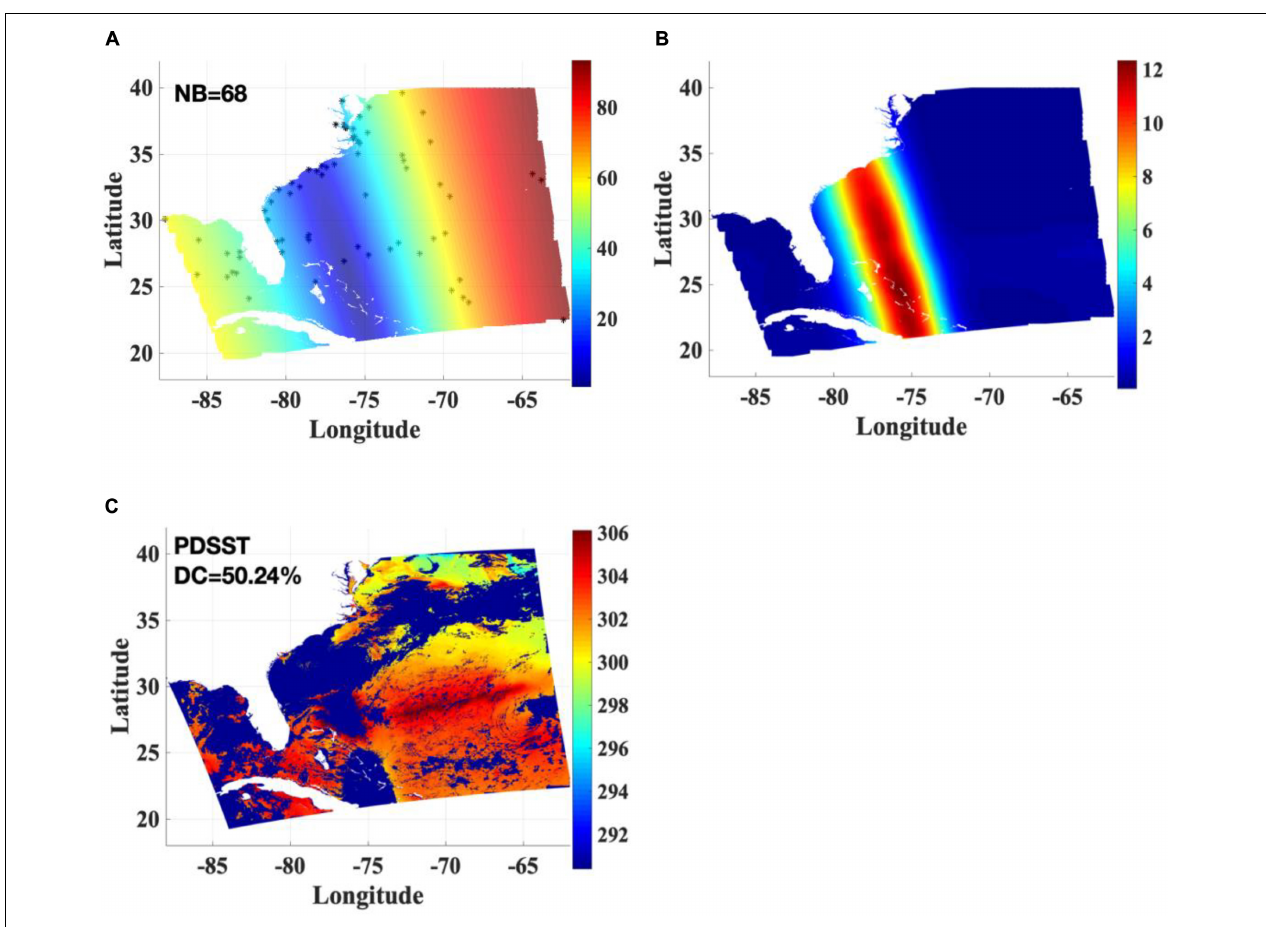
FIGURE 1 | Single swath maps: (A) Specular angle ( θ spec ) and the locations of in situ (Unit of color bar is degree), (B) Differences of the simulated BTs of 3.9 µ m channel between daytime and “nighttime equivalent” using CRTM (Unit of color bar is K), and (C) Retrieved SSTs using PDSST-suite (Unit of color bar is K). In situ locations are plotted using “*”. DC and NB stand for data coverage (cloud-free pixels) and the numbers of buoys, respectively. The ranges of longitude and latitude from − 180 ◦ to 180 ◦ and from − 90 ◦ to 90 ◦ represent West to East and South to North,